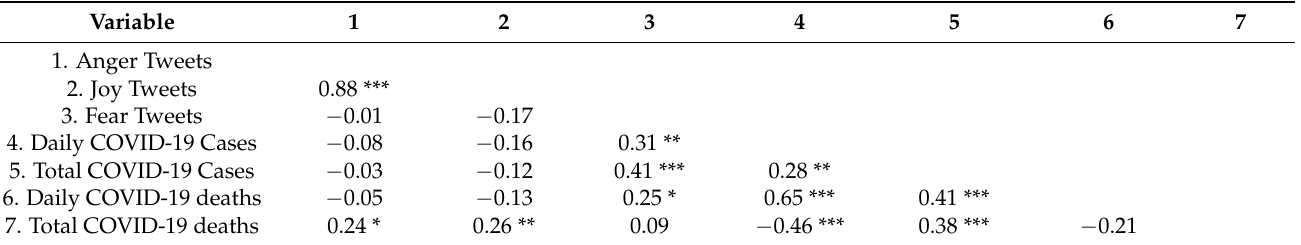
Table A7. Naples Pearson’s correlation coefficient